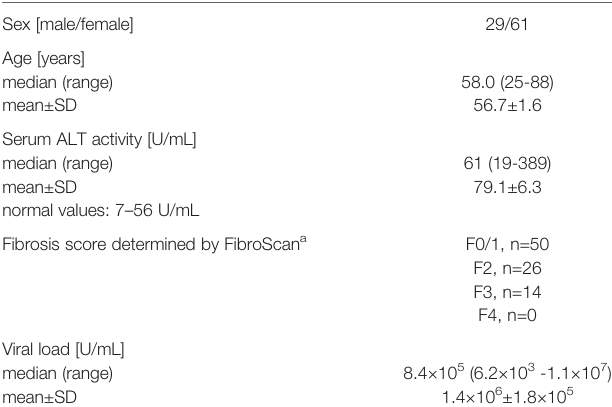
TABLE 1 | Clinical, laboratory and virological characteristics of 90 patients with chronic hepatitis